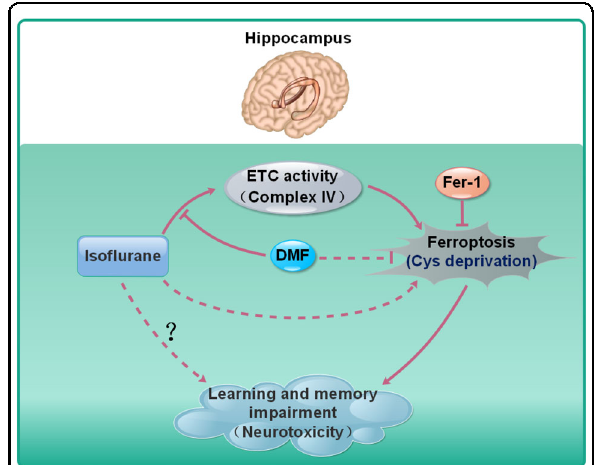
Fig. 7 Proposed model for the relationship among iso fl urane, ferroptosis and learning and memory impairment in hippocampus. Iso fl urane exposure induces ferroptosis in hippocampus and leads to learning and memory impairment. Iso fl urane also increased the activity of cytochrome c oxidase/ Complex IV in mitochondrial ETC, which is essential for cysteine deprivation-induced ferroptosis. The effect of iso fl urane on Complex IV can be rescued by DMF, but not